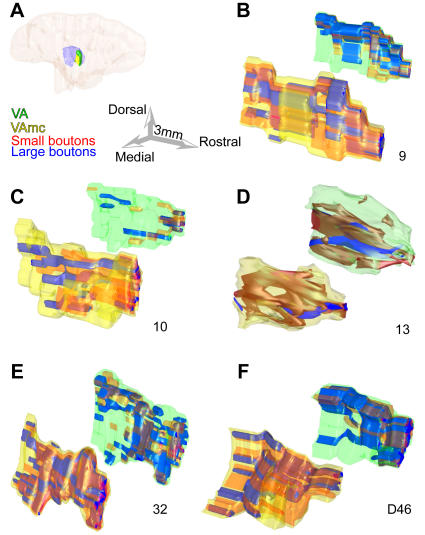
Large and small bouton populations in the ventral anterior nucleus.Separate reconstructions are shown for the principal nucleus (VA) and its magnocellular part (VAmc). A, Reconstructed hemisphere of a rhesus monkey brain, shown from the medial surface, which was rendered transparent to show the position of the ventral anterior nuclei (VA: green; VAmc: yellow) surrounded by the thalamic reticular nucleus (purple). B–F, Three-dimensional (3D) reconstruction of the topographical distribution of large (blue) and small (red) boutons from prefrontal axons in the ventral anterior nuclei. The VAmc is in the foreground and appears larger in 3D space, but it is actually smaller. For details about the size of each nucleus see text. Numbers below each pair show the prefrontal cortical origin of boutons from areas 9, 10, 13, 32 and D46.